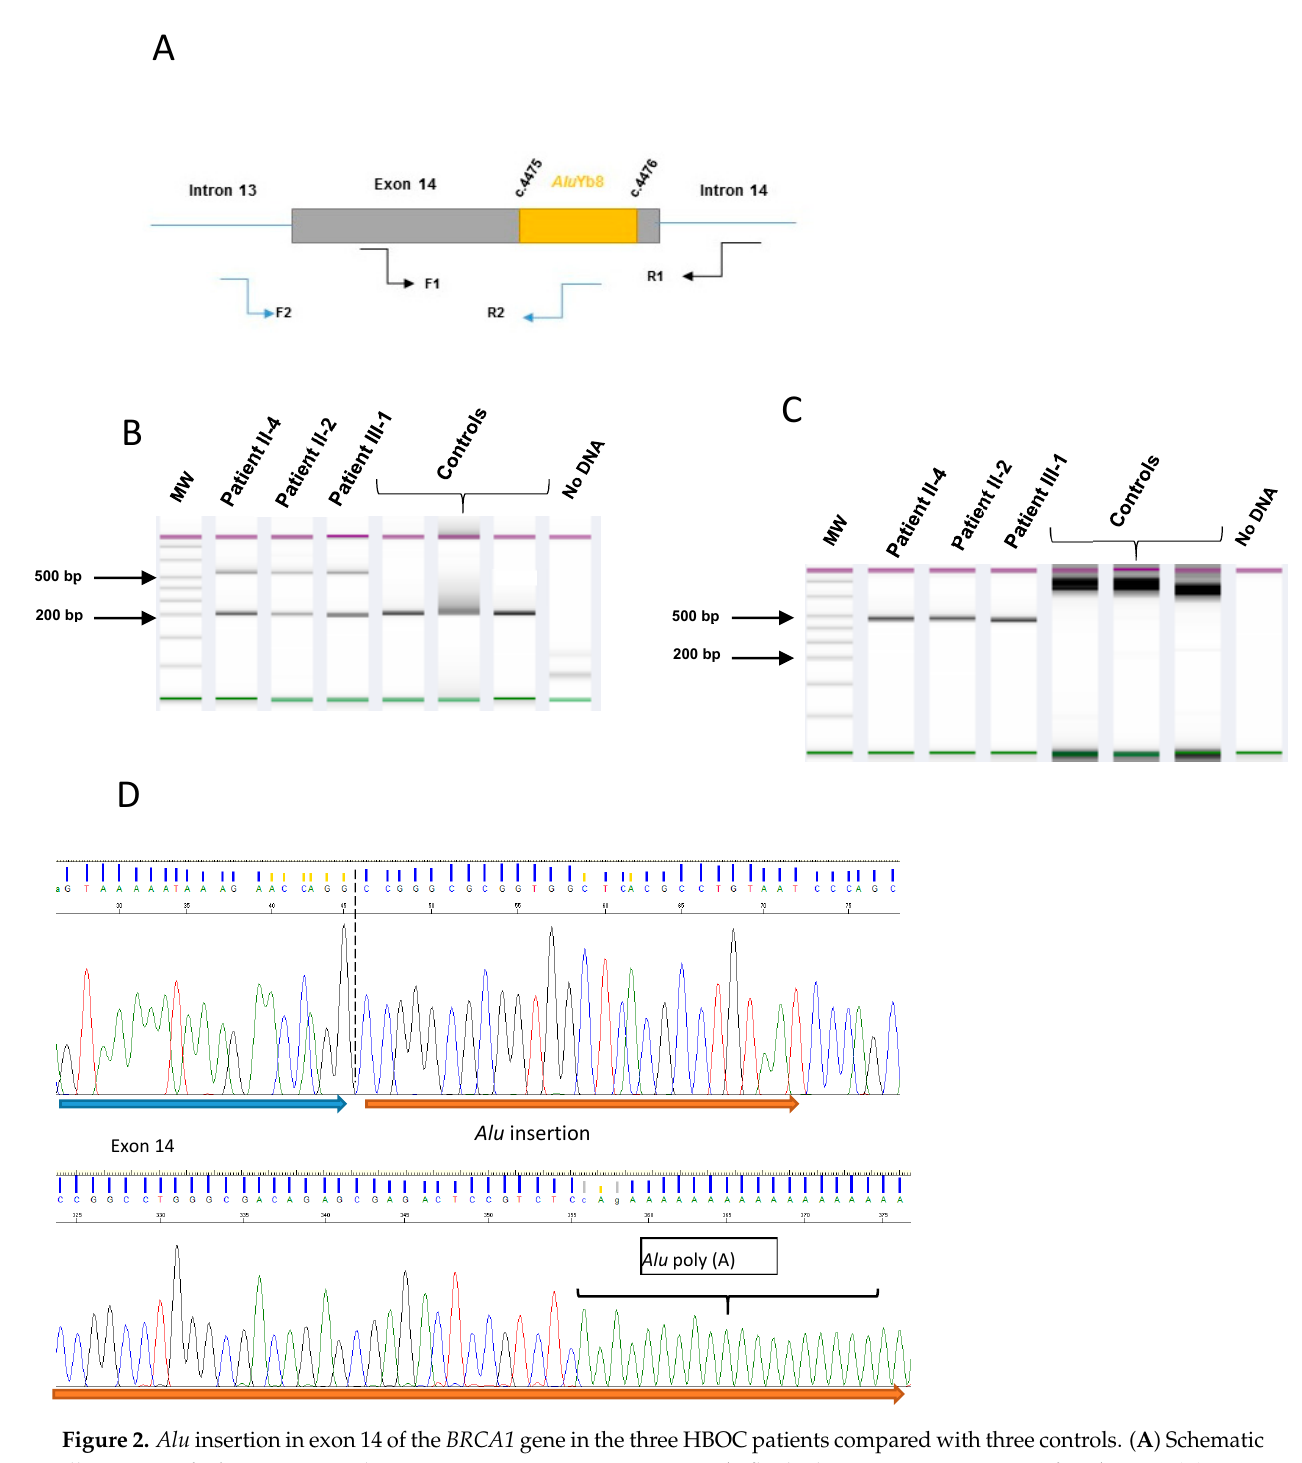
Figure 2. Alu insertion in exon 14 of the BRCA1 gene in the three HBOC patients compared with three controls. ( A ) Schematic illustration of Alu insertion and PCR primer position. PCR F1-R1: Alu flanked PCR, PCR F2-R2: Specific Alu PCR. ( B ) Automated gel electrophoresis using the TapeStation detection system of the Alu flanking PCR products—a supplementary 524 bp band was shown in patients and not in controls. ( C ) Specific Alu PCR: the expected 450 bp fragment from patient samples and no specific bands observed from control samples. ( D ) Identification of the insertion by Sanger sequencing